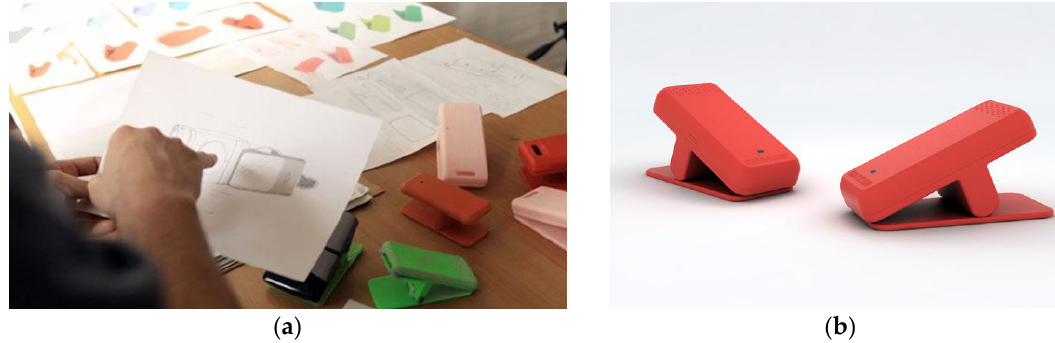
Figure 7. Image of the design process and different prototypes ( a ) and the final design ( b ).